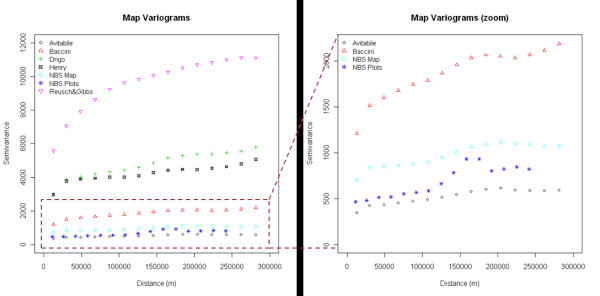
Variograms of the biomass maps and NBS field plots. The right figure shows a zoom of the variograms for semivariance values between 0 and 2500.